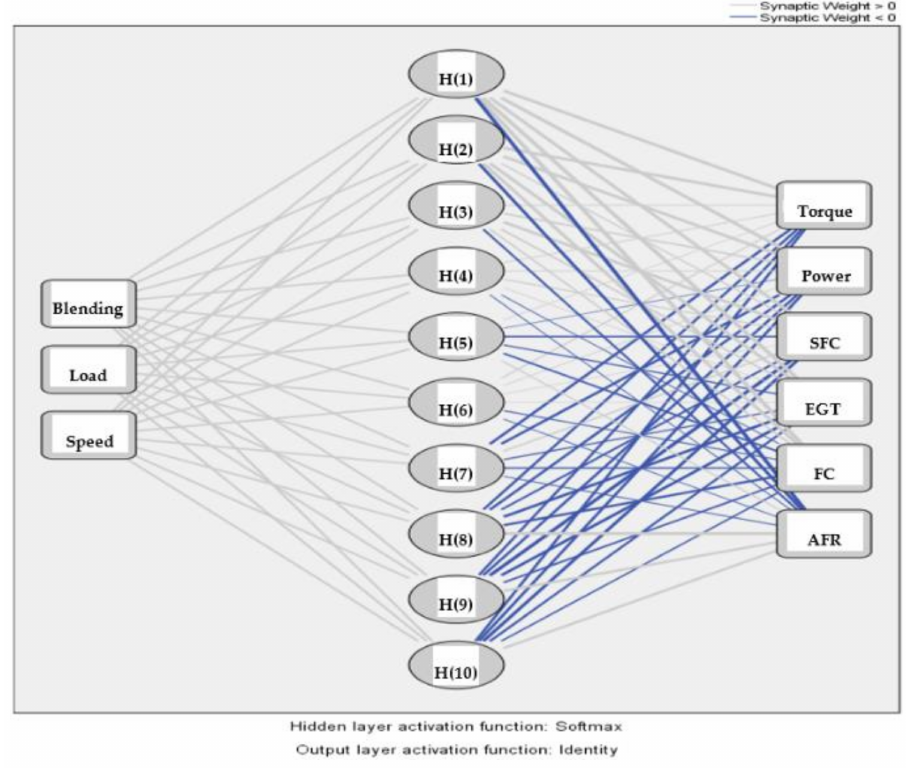
Figure 7. Neural Network